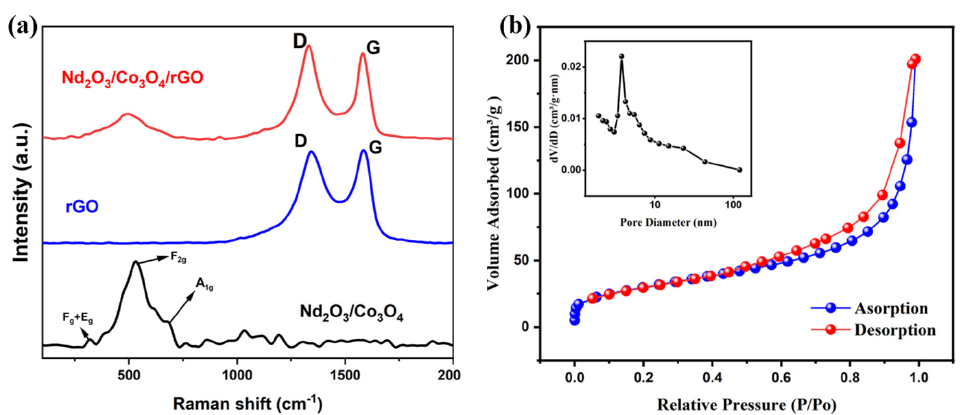
Figure 5. ( a ) Raman spectra of Nd 2 O 3 /Co 3 O 4 /rGO/NF; ( b )Nitrogen adsorption and desorption isotherm of Nd 2 O 3 /Co 3 O 4 /rGO with the pore size distribution in the insets. The constituent phases of Nd 2 O 3 /Co 3 O 4 /rGO/NF were characterized by XRDas shown in Figure 6a. The characteristic peaks of metallic nickel, which correspond to the (111), (200), and (220) crystal planes of metallic nickel, are positioned at 44.3 ◦ , 51.7 ◦ , and 76.2 ◦ , respectively. These predominant peaks are easily noticeable in the image (JCPDS card No. 04-0850). Additionally, the (220), (311), and (422) crystallographic planes of Co 3 O 4 are represented by 31.3 ◦ , 36.9 ◦ , and 55.66 ◦ in the curve respectively, going to describe the 2 θ equal to 28.6 ◦ , 40.9 ◦ , and 59.2 ◦ in Figure 6a all correspond to the (110), (200), and